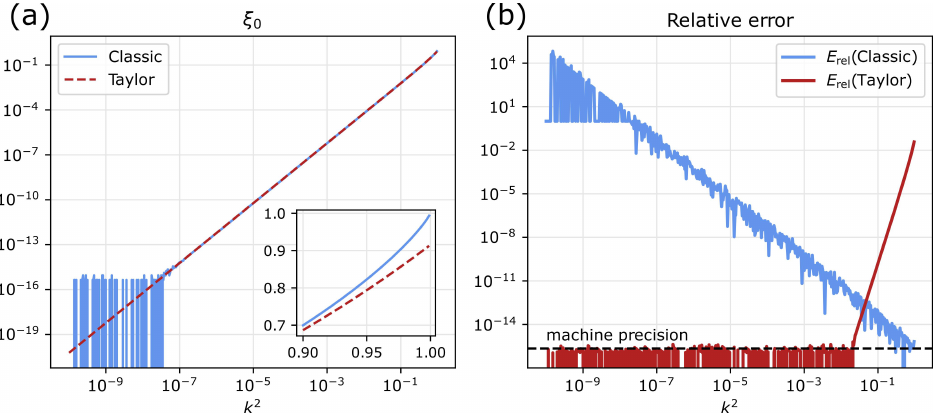
Figure 4. ( a ) Two different implementations of the function ξ 0 and ( b ) the relative difference when comparing them to each